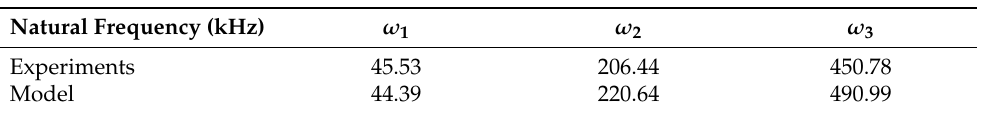
Table 2. Measured vs. calculated natural frequencies of the microbeam subject to half-electrode actuation ( V DC = 2.45V).